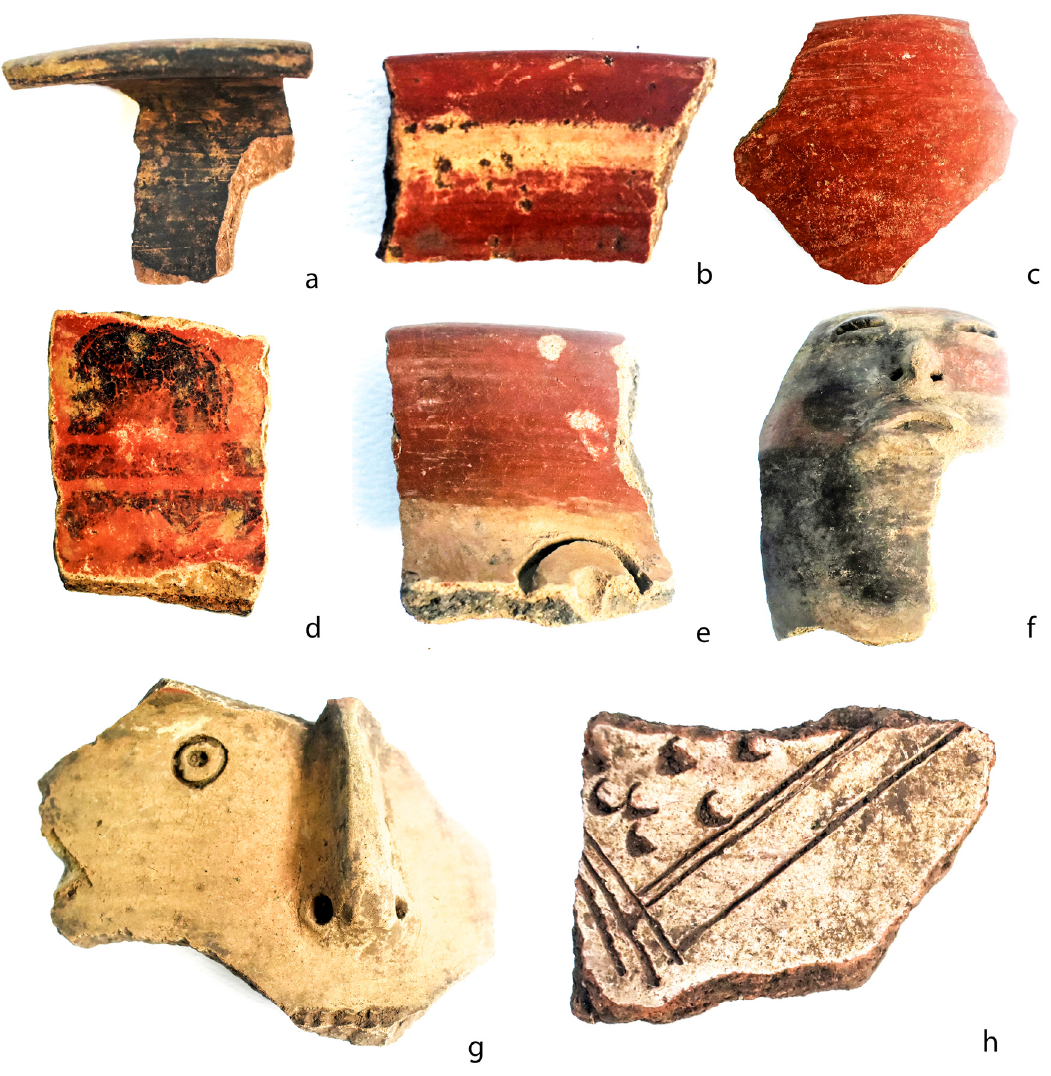
Figure 2. Ceramic styles are recorded in the archeological landscape of the Chanchán Basin. ( a ) Pol- ished brown; ( b ) red on fine fawn; ( c ) red slipped; ( d ) negative; ( e ) red slipped on fawn; ( f ) ocher slipped; ( g ) fawn smoothed; ( h ) incised white.